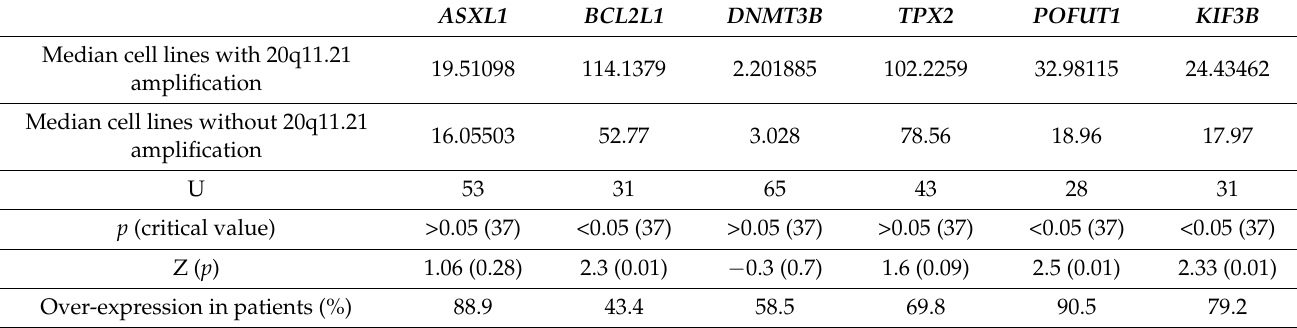
Table 5. Comparison of mRNA expression of genes at 20q11.21 in cell lines with and without 20q11.21 amplifications. ASXL1 BCL2L1 DNMT3B TPX2 POFUT1 KIF3B Median cell lines with